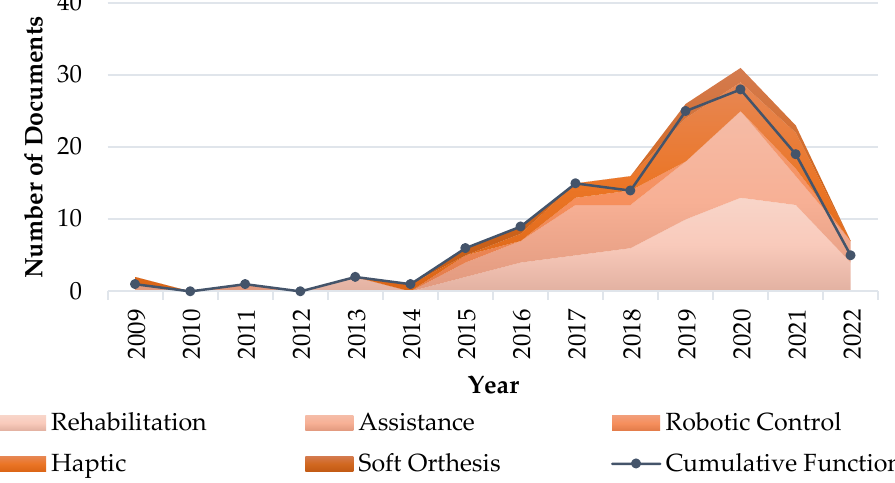
Figure 10. Evolution in time of the soft gloves application fields categories. Data are presented in stacked format, with the total amount of documents for each year in black line with dots.